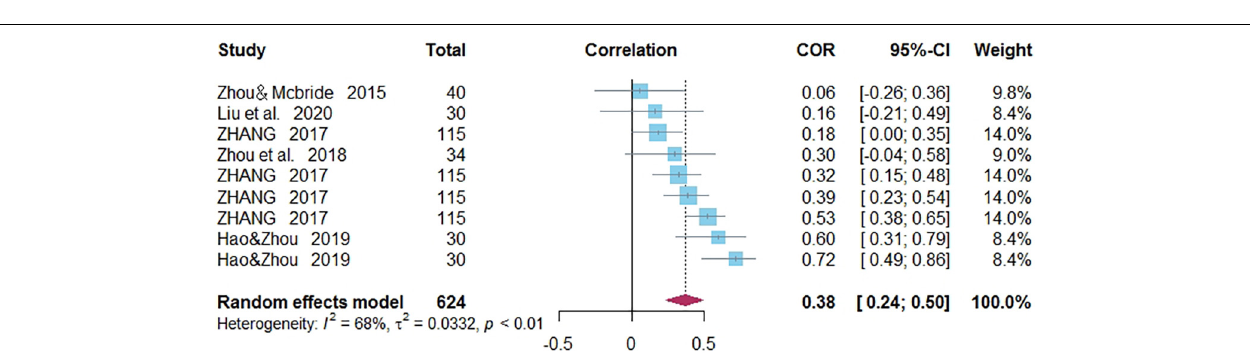
FIGURE 5 | Funnel plot of effect sizes vs. standard error for morphological awareness and Chinese word reading.